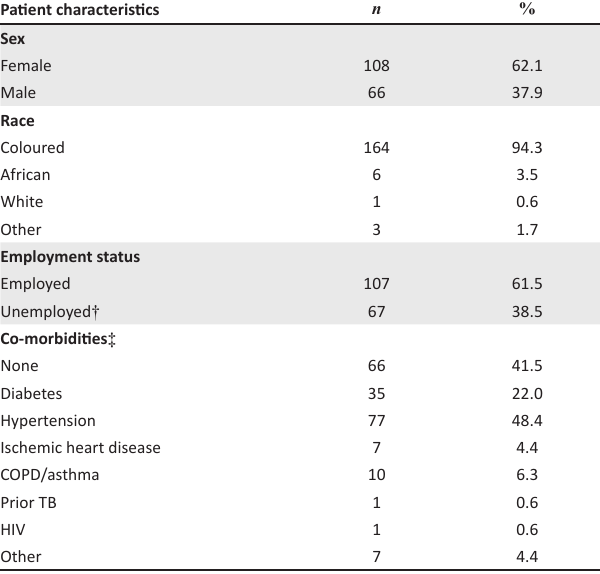
TABLE 1: Baseline patient characteristics.